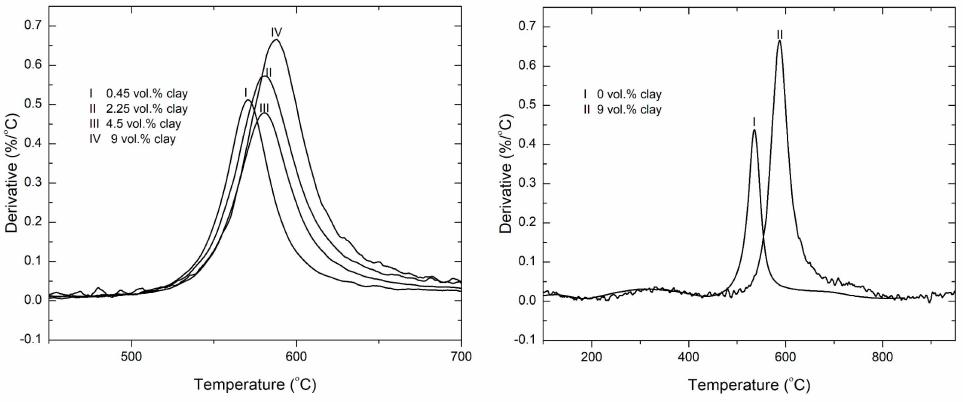
Figure 4. Derivative TGA curves of PI-NGS-Clay nanocomposites in nitrogen atmosphere at a heating rate of 30 ◦